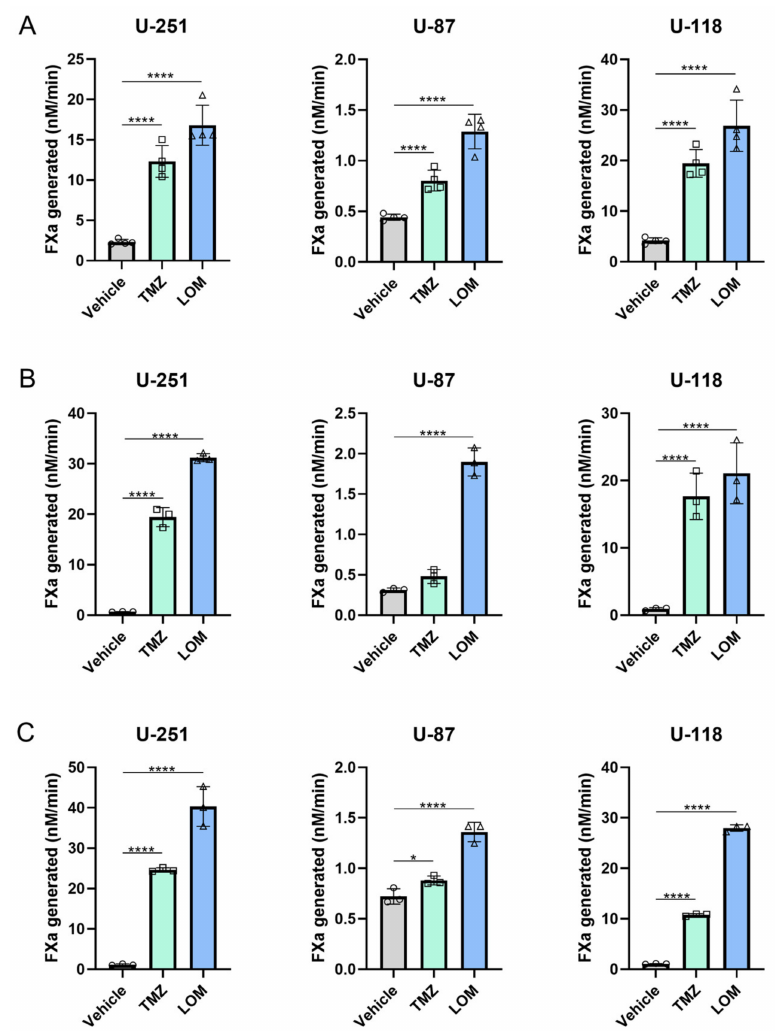
Figure 1. Chemotherapeutic agents TMZ and LOM induce procoagulant activity in GBM cells in vitro. U-251, U-87 and U-118 GBM cells were treated with 100 µ M TMZ or 30 µ M LOM for 72 h. An FXa generation assay was performed to determine procoagulant activity in substrate-attached cells ( A ), supernatant ( B ) and samples largely enriched for EVs ( C ). The amount of generated FXa was measured 30 min after the start of the reaction in the presence of 1 nM FVIIa and 50 nM FX and corrected for cell number per sample. Representative experiments are shown ( n = 3) from biological triplicates for each condition. Two-way ANOVA with Tukey’s multiple comparison test was used for statistical evaluation. * p < 0.05, **** p < 0.0001 vs vehicle (DMSO). Abbreviations: FXa, factor Xa; TMZ, temozolomide; LOM,